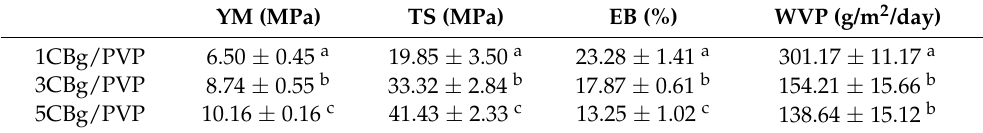
Figure 3. ( a ) Tensile testing of CBg/PVP films with different mass concentrations. ( b ) Photograph of 3% CBg/3% PVP film. Table 1. Mechanical properties and WVP of CBg/PVP films with different mass